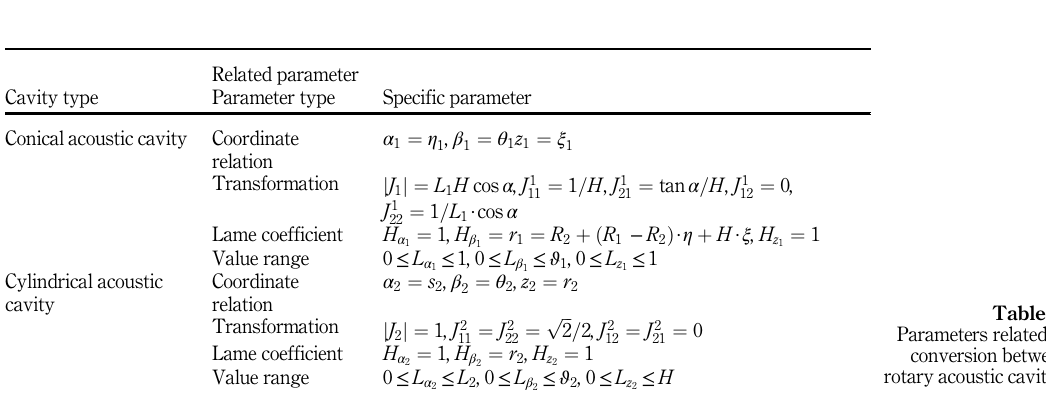
Table 1. Parameters related